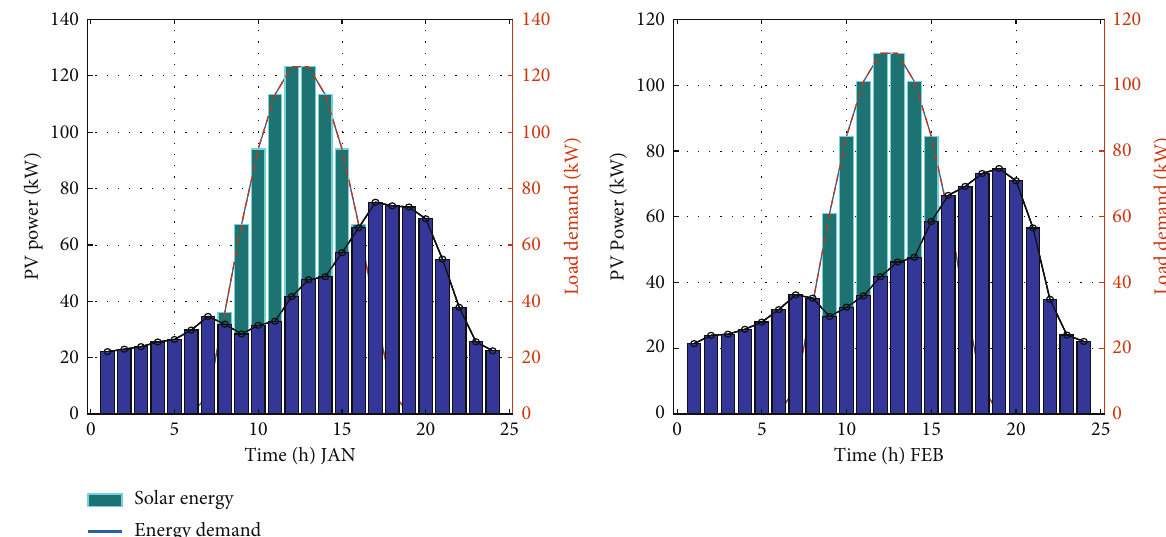
Figure 13: Comparison of load demand and SPV power produced from January to February.